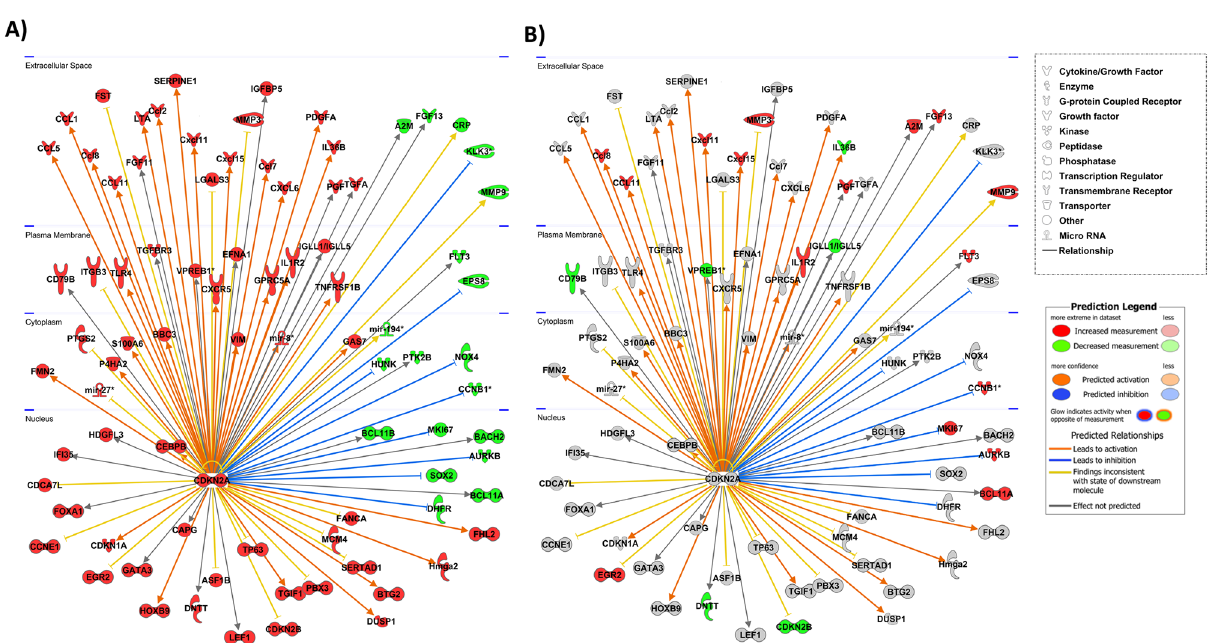
Figure 7. Activation of CDKN2A and associated network. Functional analysis using Ingenuity’s pathway analysis (IPA) predicted activation of CDKN2A. ( A ) Shows downstream transcripts that are deregulated in IM vs CTX and the direction of deregulation, predicting activation of CDKN2A in the IM. ( B ) Based on the expression pattern, the level of activation id disturbed in NFAT-KO IM vs. control IM. Red and green shaped molecules indicate increased and decreased expressions, respectively. The orange/red lines indicate activation, the blue lines indicate inhibition, and yellow lines indicate findings inconsistent with the state of downstream activity. The grey lines indicate that the effect was not